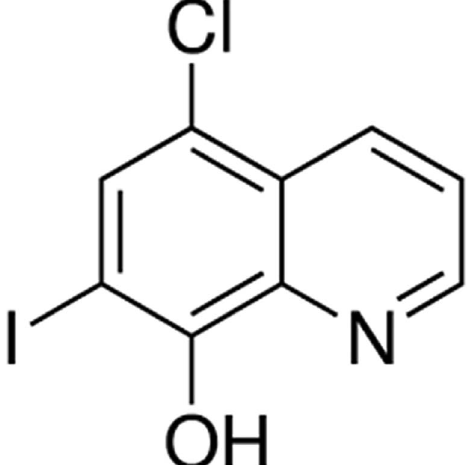
Figure 1. Chemical structure of the clioquinol (ICHQ)